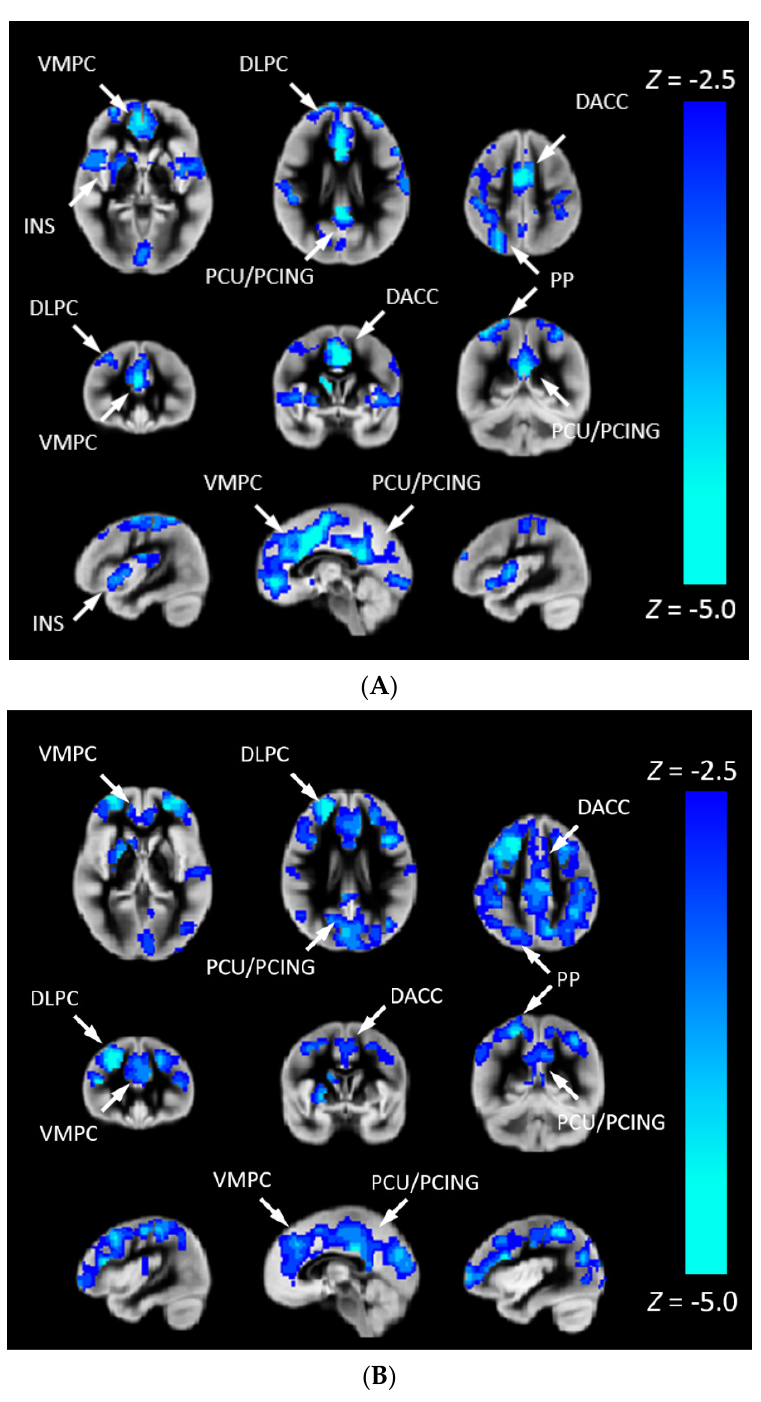
Figure 2. ( A ) Pnvf is reduced in children and younger adults with congenital heart disease (CHD) compared to normal referents. ( B ) Pnvf is reduced in children and younger adults with single ventricle congenital heart disease (CHD) compared to bi-ventricular congenital heart disease. Regions with decreased Pnvf (controlling for age and gender) are mainly concentrated in default mode network (DMN), central executive network (CEN), and salience network (SN) regions. All regions significant at FDR-corrected q < 0.05. Abbreviations: Ventrolateral medial prefrontal cortex (VMPC), Insula (INS), Dorsolateral prefrontal cortex (DLPC), Posterior Cingulate (PCING), Precuneus (PCU), Dorsal Anterior Cingulate Cortex (DACC), Posterior Parietal